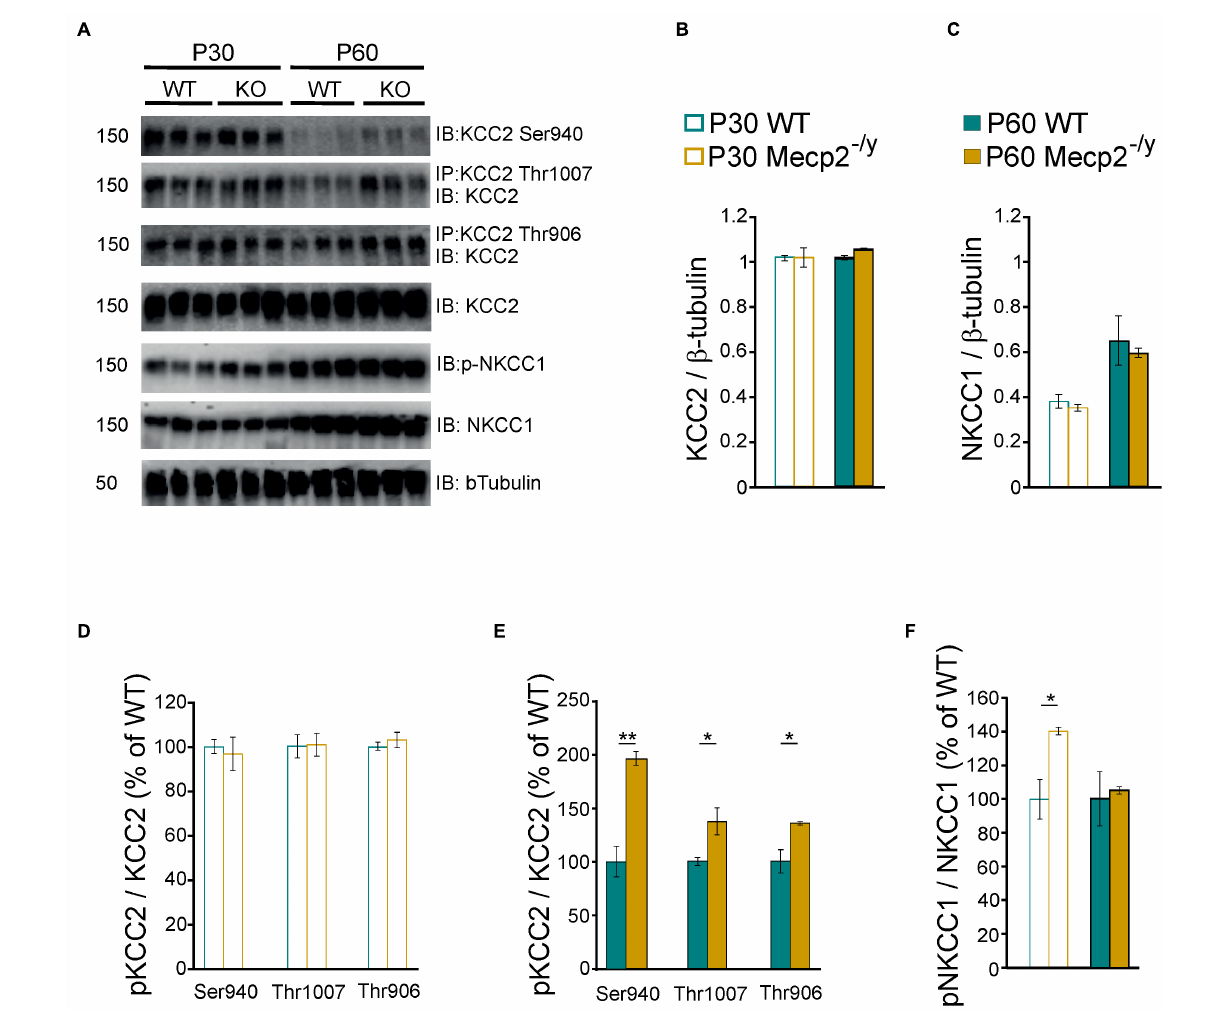
FIGURE 3 | Protein expression of KCC2 and NKCC1 in wild-type and Mecp2 - / y hippocampi. Western blots (A) and quantifications of KCC2 (B) , NKCC1 (C) , and the phosphorylated forms of KCC2 (D,E) and NKCC1 (F) in P30–35 and P50–60 WT and Mecp2 - / y hippocampi. n = 3 for both. Mean + SEM. * P < 0.05, ** P < 0.01, two-tailed unpaired Student’s t